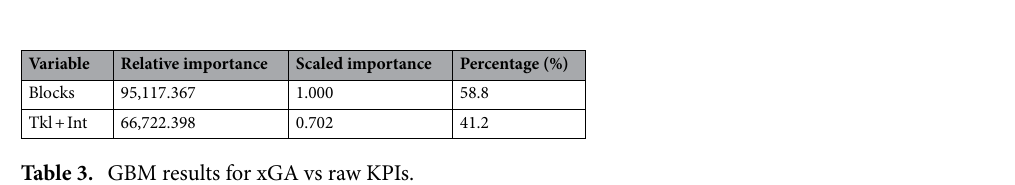
Table 3. GBM results for xGA vs raw KPIs.